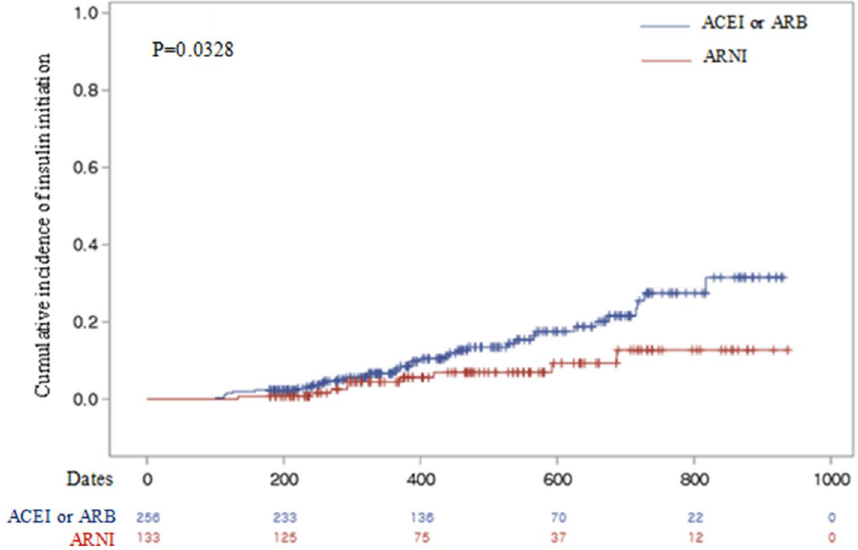
Figure 3. Kaplan–Meier curve showing the time to insulin initiation in patients from the ARNI and ACEI or ARB groups who were not treated with insulin